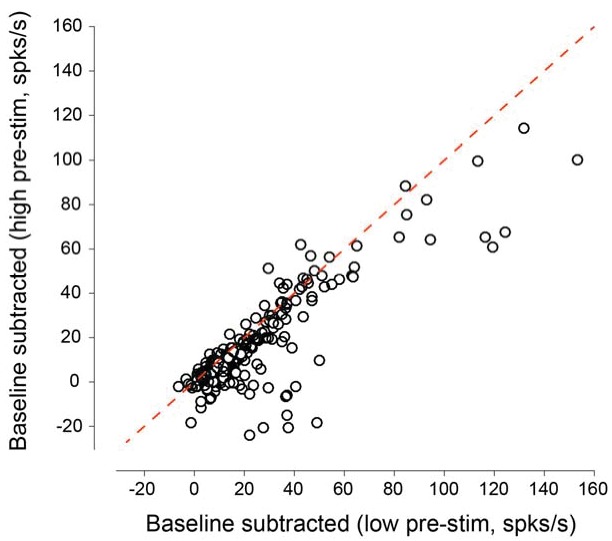
Baseline-subtracted evoked responses as a function of pre-stimulus response state for all the neurons recorded in the behavioral experiments.Subtracting the 200 ms pre-stimulus activity from the evoked response reveals that the baseline-subtracted responses in the low pre-stimulus state are higher than those in the high pre-stimulus state (mean responses: 21.95 ± 1.58 vs. 14.88 ± 1.38 spks/s, p=4.73 10−16, paired t-test). The plot above indicates that evoked_low – baseline_low > evoked_high – baseline_high.This is equivalent to evoked_high – evoked_low  < baseline_high – baseline_low. That is, fluctuations in evoked responses during wakefulness are smaller than the fluctuations in ongoing activity.